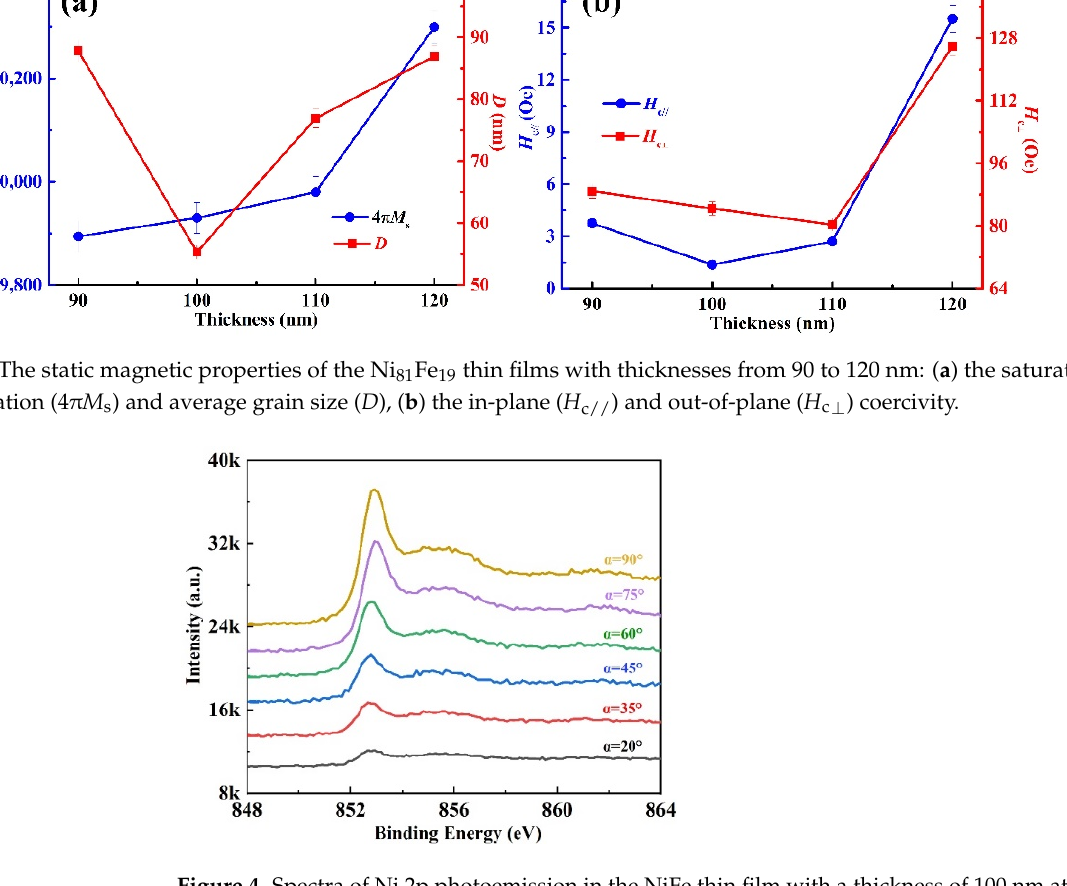
Figure 2. The magnetic hysteresis ( M-H ) loops of NiFe thin films with thickness from 90 to 120 nm: ( a ) the in-plane mag- netic hysteresis loops, ( b ) the out-of-plane magnetic hysteresis loop. Table 1. The values of density, molecular weight, and kinetic energy for Ni, NiO, and Ni(OH) 2 , as well as R ∞ for both nickel oxides.